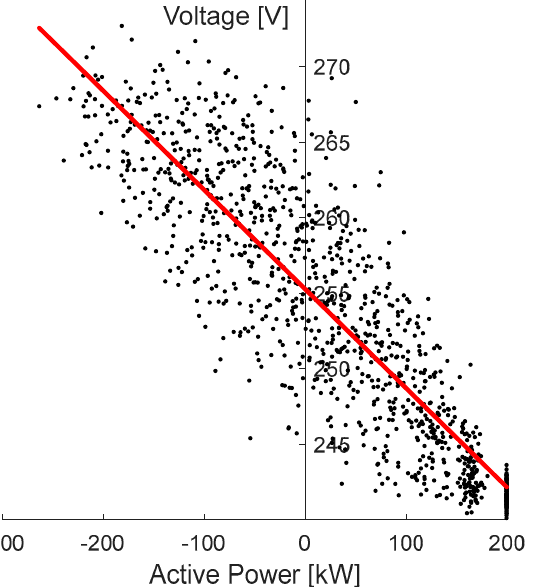
Figure 5. Maximum voltage in the day versus the corresponding active power drawn by the trans- former.